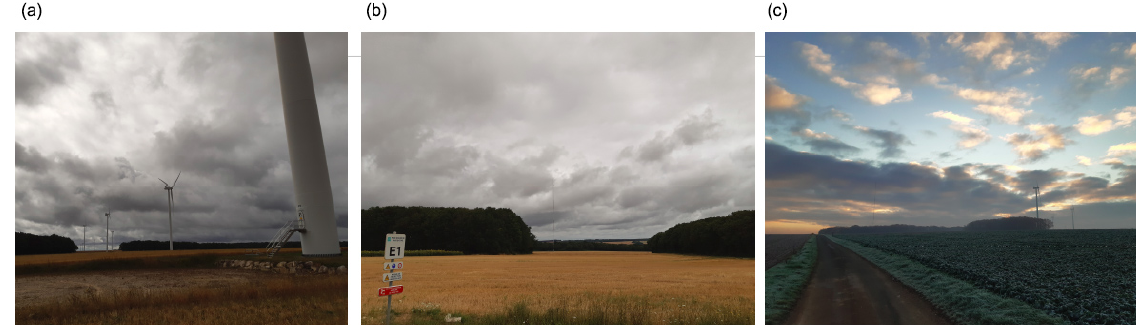
Figure 3. Pictures of the Pays d’Othe wind farm. (a) Picture of the wind farm taken from the wind turbine closest to the mast. (b) Picture of the meteorological mast taken from the wind turbine closest to it. (c) Picture of the mast (left of the picture) and the wind farm (right of the picture) taken from the road just north of the mast. Pictures were taken by Auguste Gires.